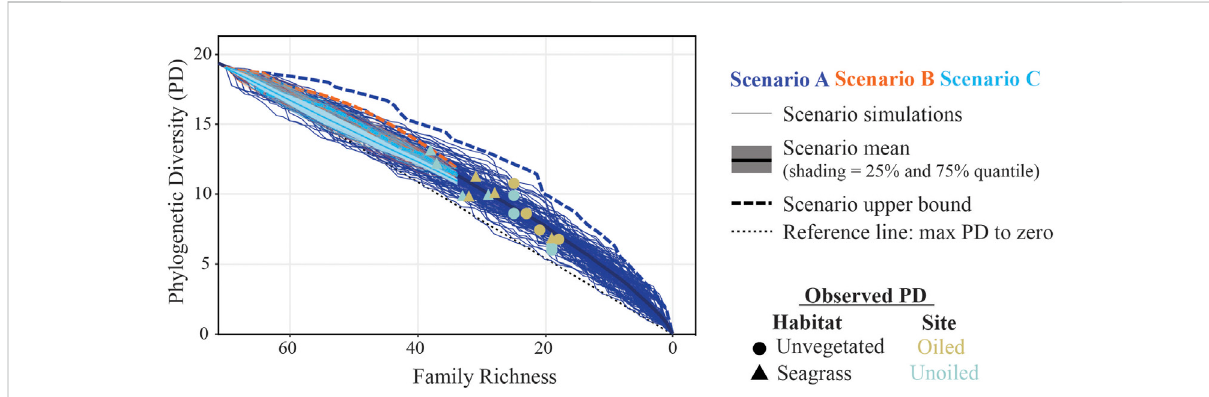
FIGURE 5 Clade loss scenarios modeling PD decline as a function of family richness. The three scenarios include: (A) single family, (B) two-family clade, and (C) three-family clade iterative PD loss. Iterations ( n = 100 per scenario) and scenario mean (with 25 and 75% shaded quantiles) are plotted. The upper bounds of each scenario and a line through the origin are provided for reference. For all scenarios, the iterations fell below what would be expected from the slowest possible rate of PD loss based on removing branches/clades ordered shortest to longest total branch length (upper bound). Individual points re fl ect PD values from each community